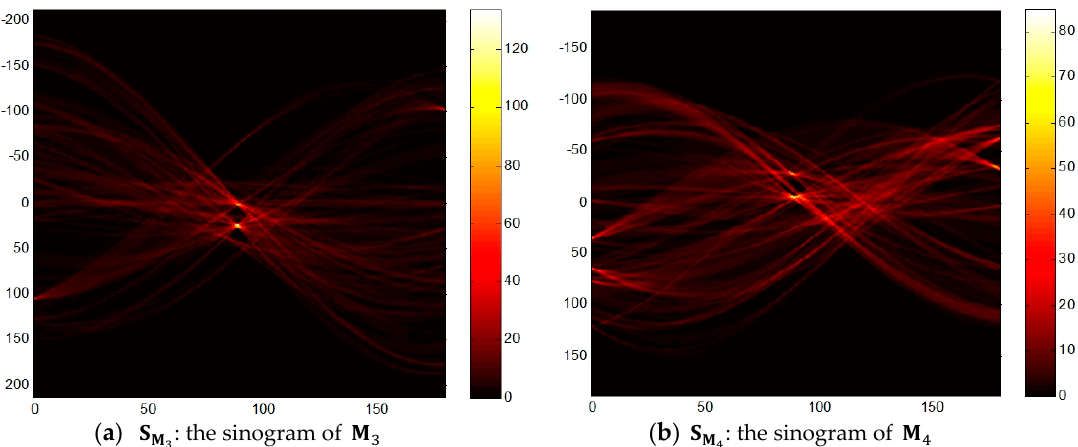
: the sinogram of 𝐌 (cid:2872) (cid:3120)